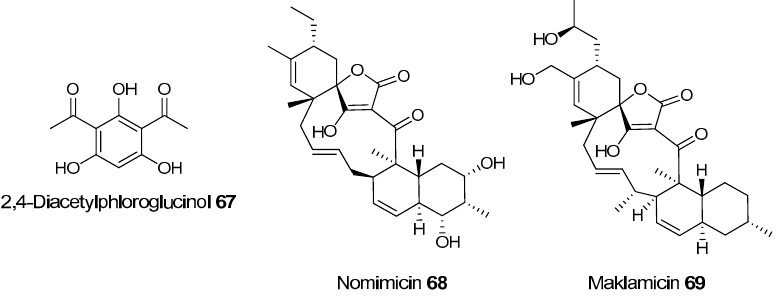
Figure 17. Natural products from disease suppressive soils.